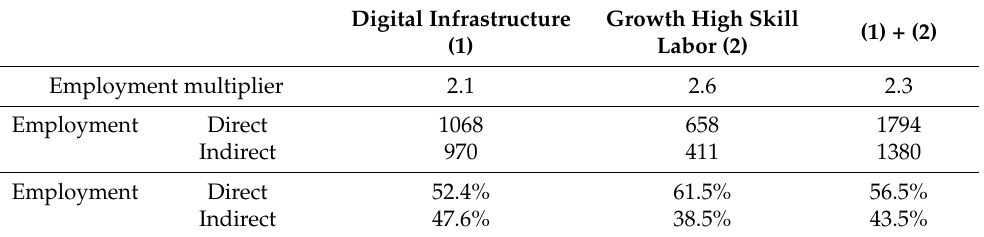
Table 8. Employment effects from digital infrastructure development (DID) reforms.